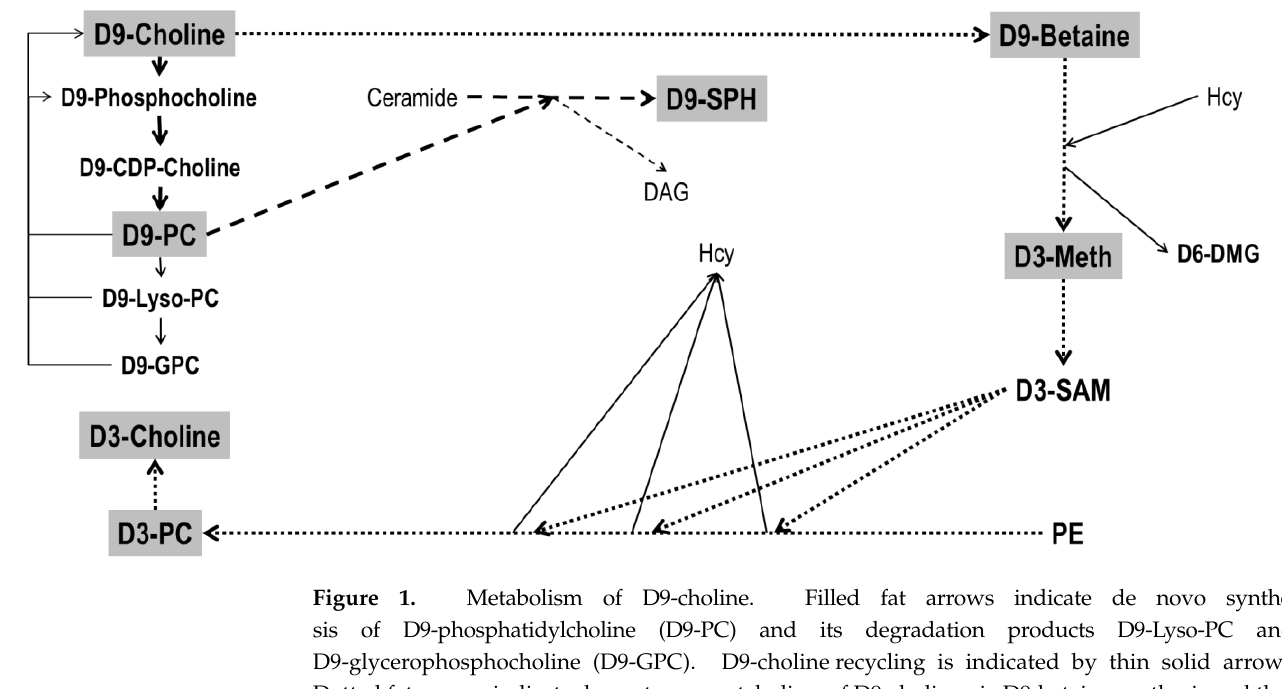
Figure 1. Metabolism of D9-choline. Filled fat arrows indicate de novo synthesis of D9-phosphatidylcholine (D9-PC) and its degradation products D9-Lyso-PC and D9-glycerophosphocholine (D9-GPC). D9-choline recycling is indicated by thin solid arrows. Dotted fat arrows indicate downstream metabolism of D9-choline via D9-betaine synthesis and that of D3-methionine (D3-Meth) from homocysteine. This is followed by D3-S-adenosylmethionine (D3-SAM) synthesis, serving 3-fold methylation of phosphatidylethanolamine (PE), predominantly resulting in D3-PC. The latter can undergo hydrolysis in analogy to D9-PC catabolism, resulting in free D3-choline. Striped fat arrows show the synthesis of D9-sphingomyelin (D9-SPH) from ceramide, using D9-PC as a donor of a D9-phosphocholine group. Further abbreviations: DAG, diacylglycerol; D6-DMG, D6-dimethylglycine. For further details and enzymes/micronutrients involved see ref [25].